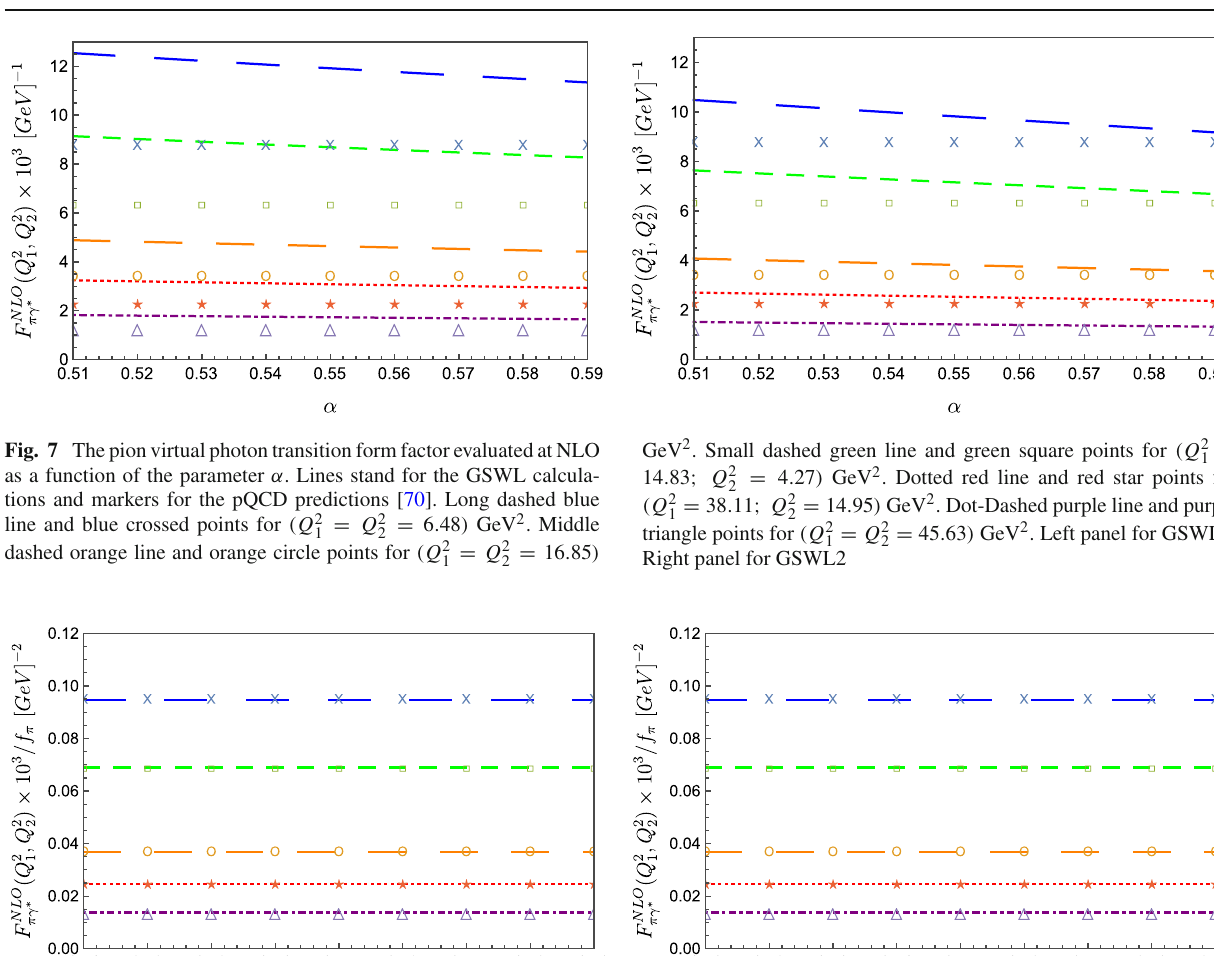
Fig. 8 Same of fig. 7 but for F πγ ∗ / f